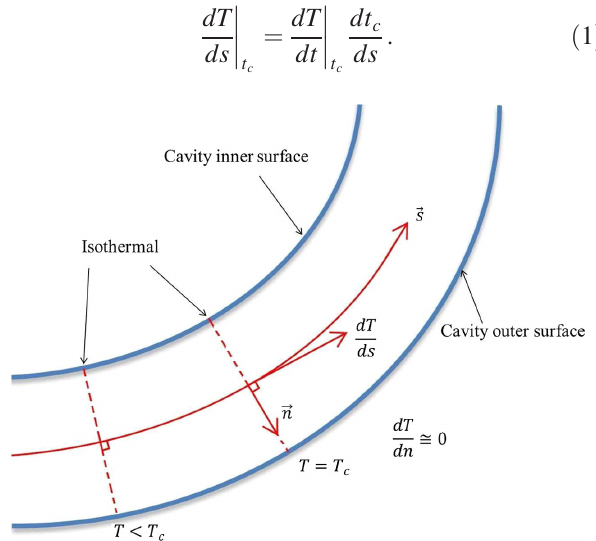
FIG. 3. Model of the temperature gradients at the phase transition front along the curved cavity